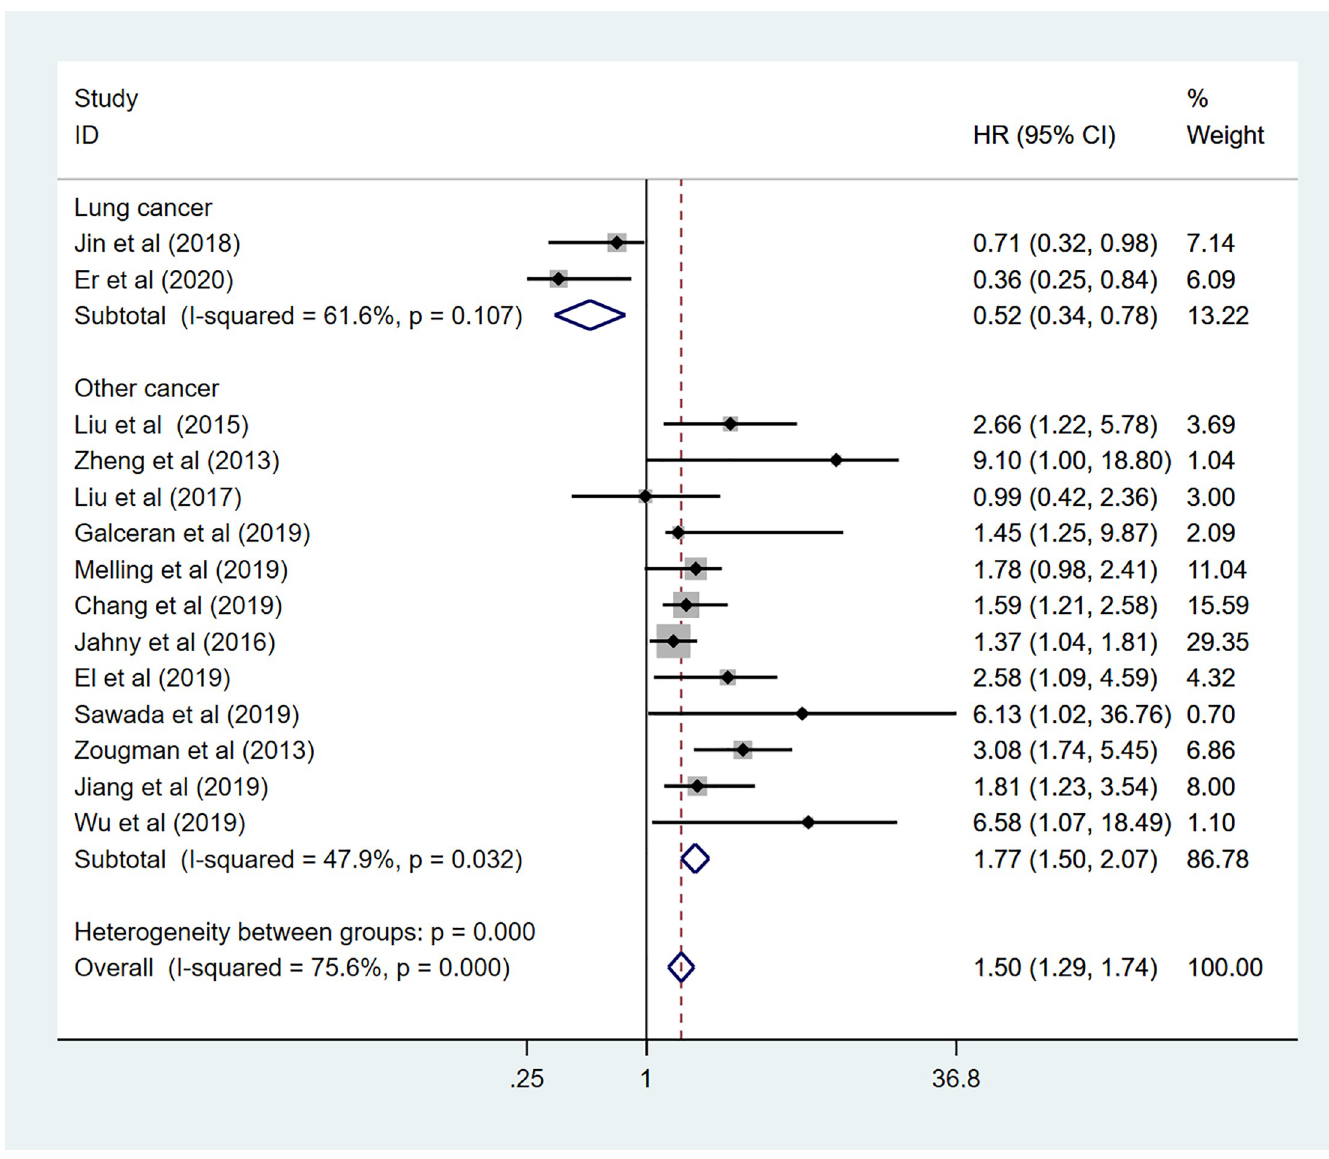
Fig 7. Forest plot for the subgroup analysis. Non-Lung